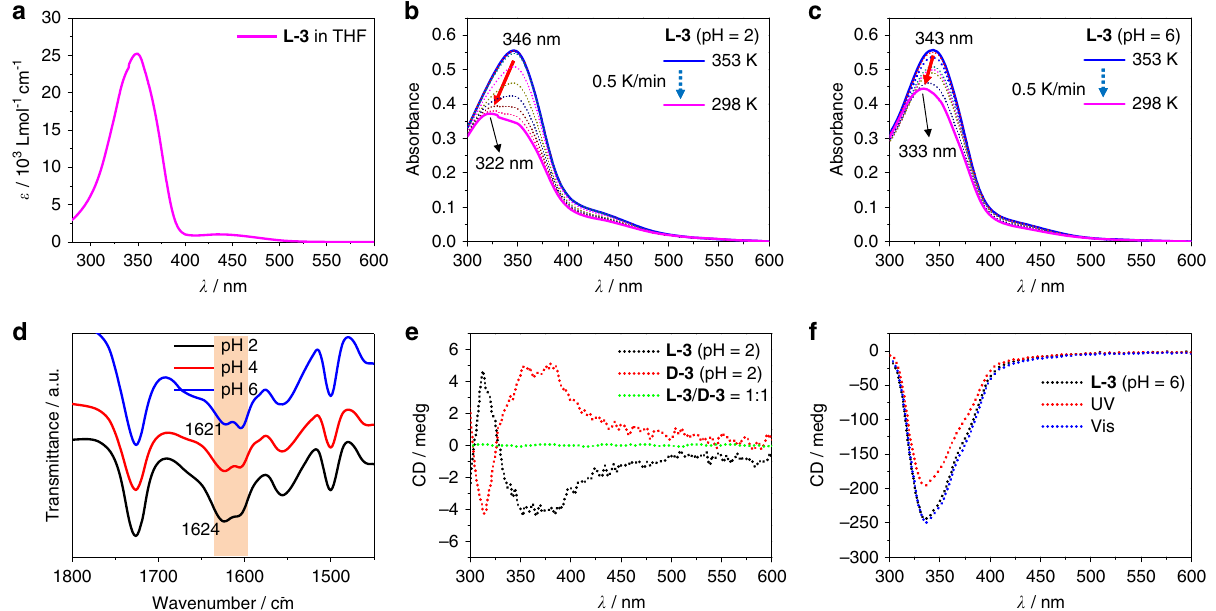
Fig. 4 Spectroscopic study of amphiphile self-assembly. a UV – vis spectrum of L-3 amphiphile in THF. [L-3] = 50 μ M, 298 K, ε max = 2.5 × 10 4 M − 1 cm − 1 at 348 nm. b Variable-temperature UV – vis spectra of L-3 amphiphile in water. [L-3] = 50 μ M, pH = 2. Cooling speed is 0.5 K/min, data interval is 5 K/ record. c Variable-temperature UV – vis spectra of L-3 amphiphile in water. [L-3] = 50 μ M, pH = 6. Cooling speed is 0.5 K/min, data interval is 5 K/record. d FT-IR spectra of self-assemblies of L-3 amphiphile in water at different pH values, blue line: pH = 6, red line: pH = 4, black line: pH = 2, [L-3] = 0.11 mM. e CD spectra of self-assemblies of L-3 (black dotted line), D-3 (red dotted line) and their 1:1 mixture (green dotted line), [L-3] = [D-3] = 50 μ M, pH = 2. f CD spectra of self-assemblies of L-3, [L-3] = 50 μ M, pH = 6, black dotted line: normal L-3 assemblies, red dotted line: L-3 assemblies after UV 365 nm irradiation for 1 h, blue dotted line: L-3 assemblies after visible light irradiation for 1